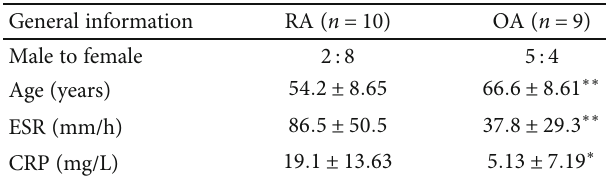
Table 3: General information of patients recruited for RT-qPCR in this